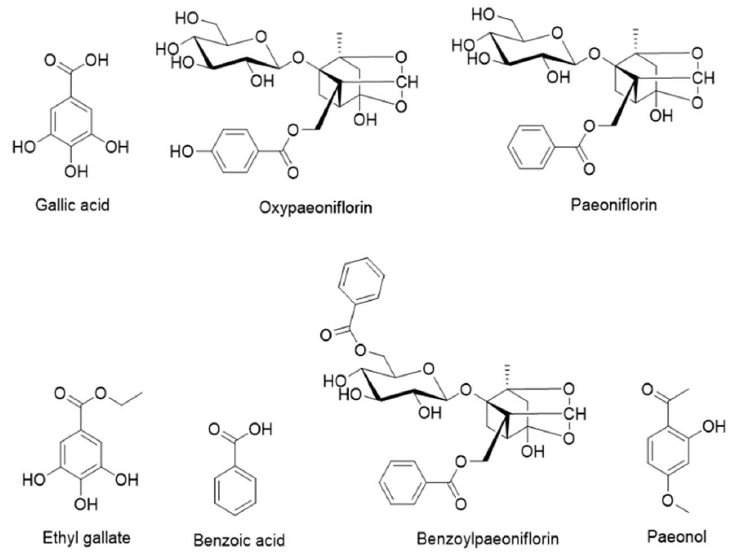
Figure 2. Chemical structures of the seven compounds of MRC analyzed in this study.